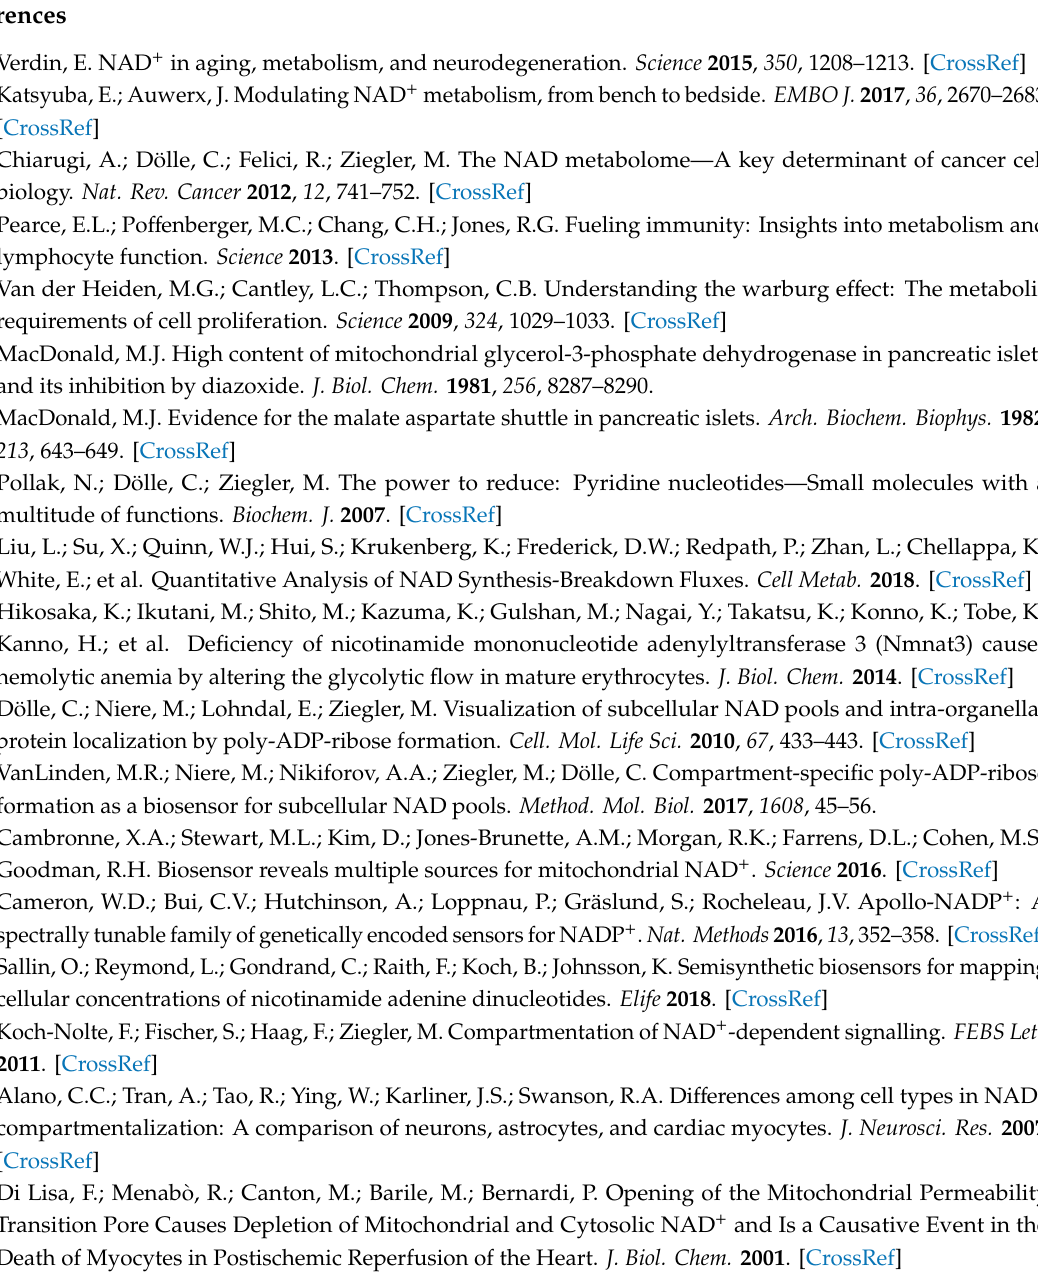
Table 2: A.-K.H. and